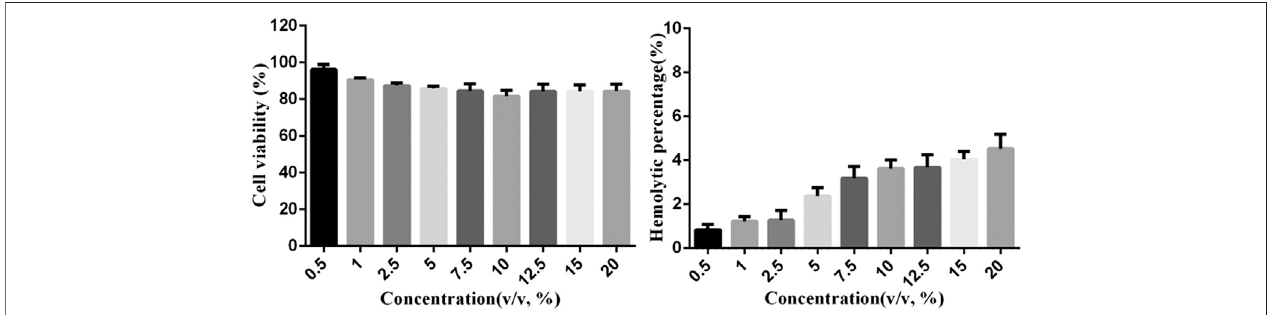
Figure4|(A) Invitro cytotoxicitywiththeMTTassay. Invitro cellviabilityofHL7702cellincubatedwithnanobubblesatdifferentconcentrationsfor24 h.Datawere reported as mean ± SD (n (cid:2) 5). (B) In vitro hemolysis experiment. The hemolysis rate of erythrocyte suspensions incubated with nanobubbles. Data were reported as mean ± SD (n (cid:2) 5).